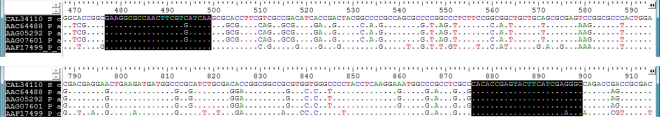
Alignment of known phzE gene sequences. Marked blocks served as the basis for primer construction.